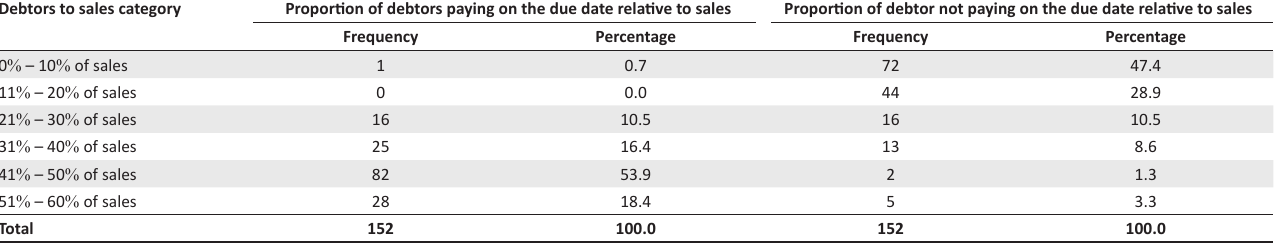
TABLE 4: Debtor payments received on the due date and not on the due date relative to sales. Debtors to sales